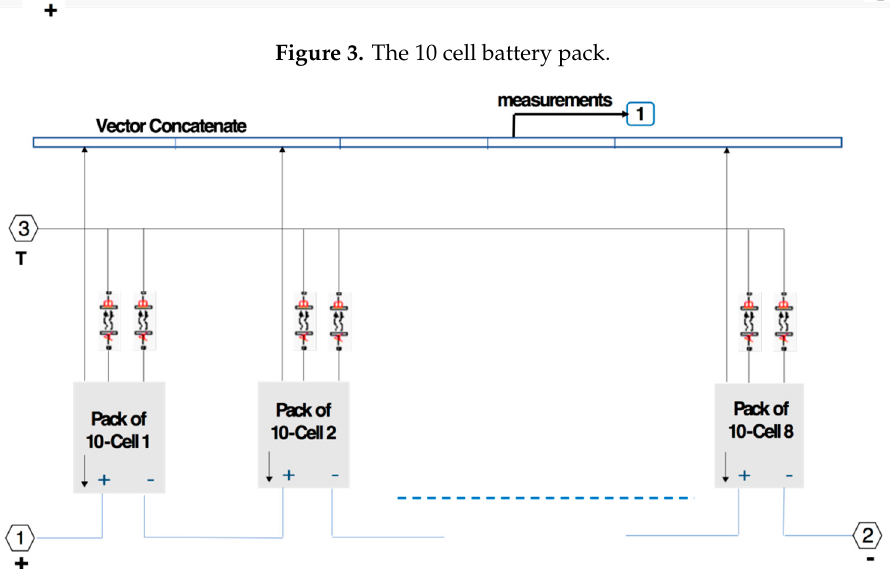
Figure 4. The 80 cell battery pack.